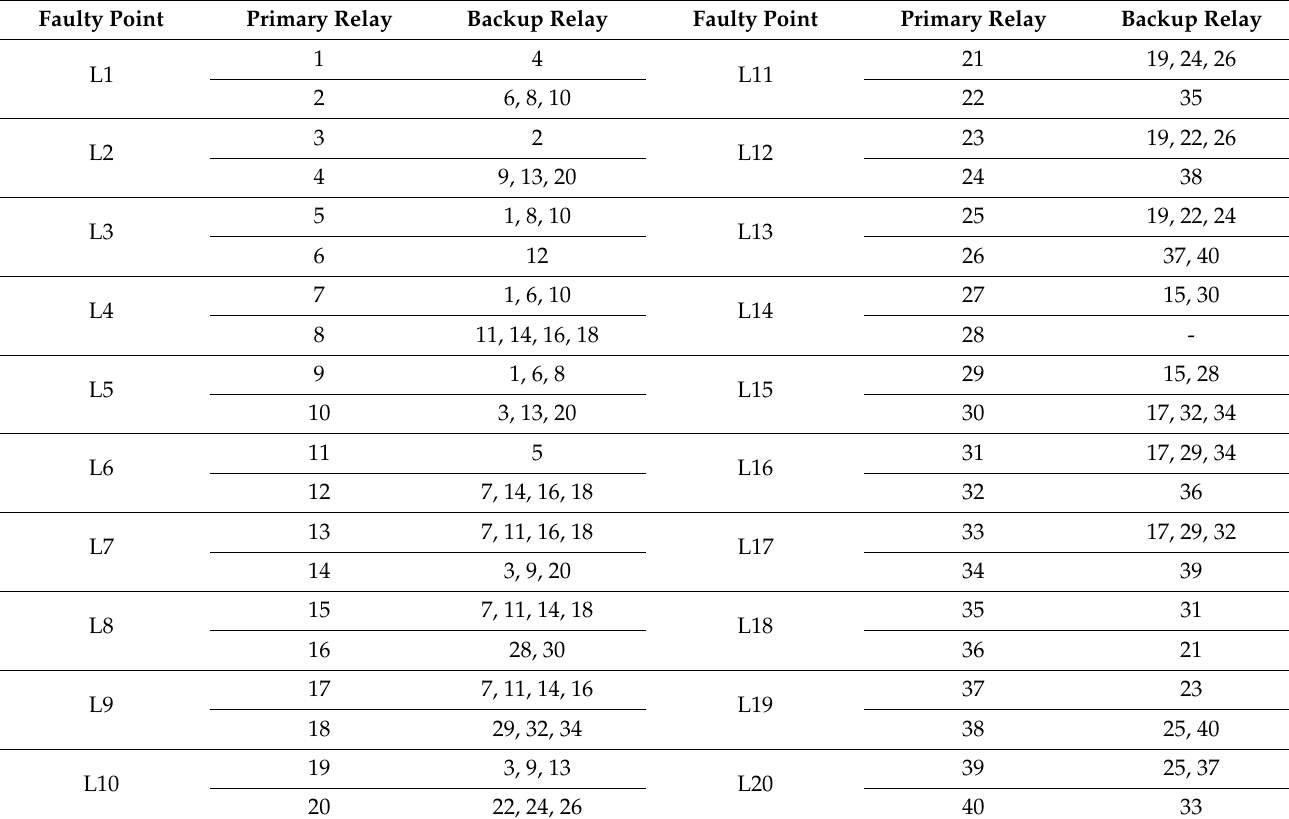
Table 7. Relationships between primary and backup relays at different fault points of IEEE 14- bus